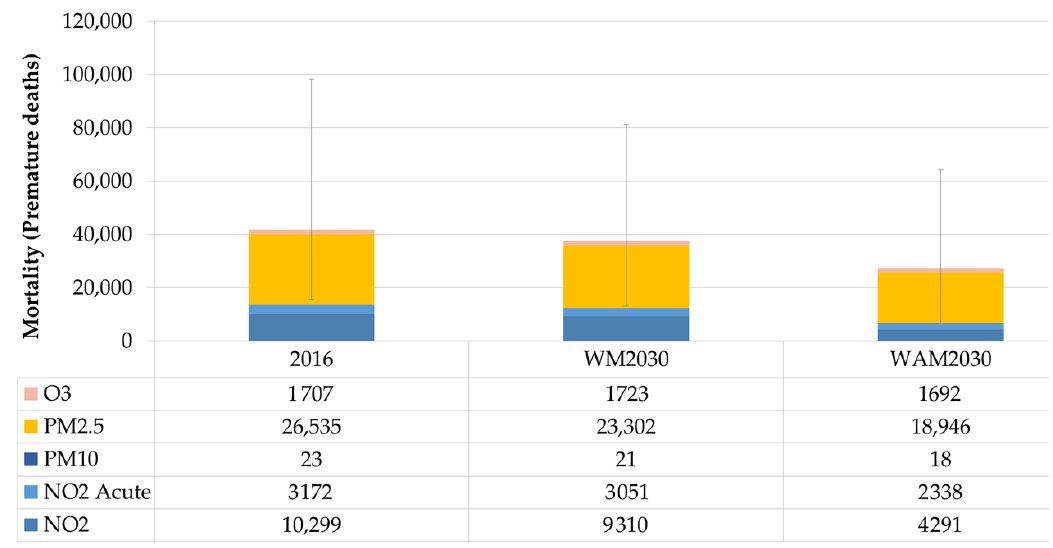
Figure 2. Mortality attributable to air pollution (NO 2 , O 3 , PM 10 , PM 2.5 ) in 2016, and scenarios with measures (WM2030) and with additional measures (WAM2030).